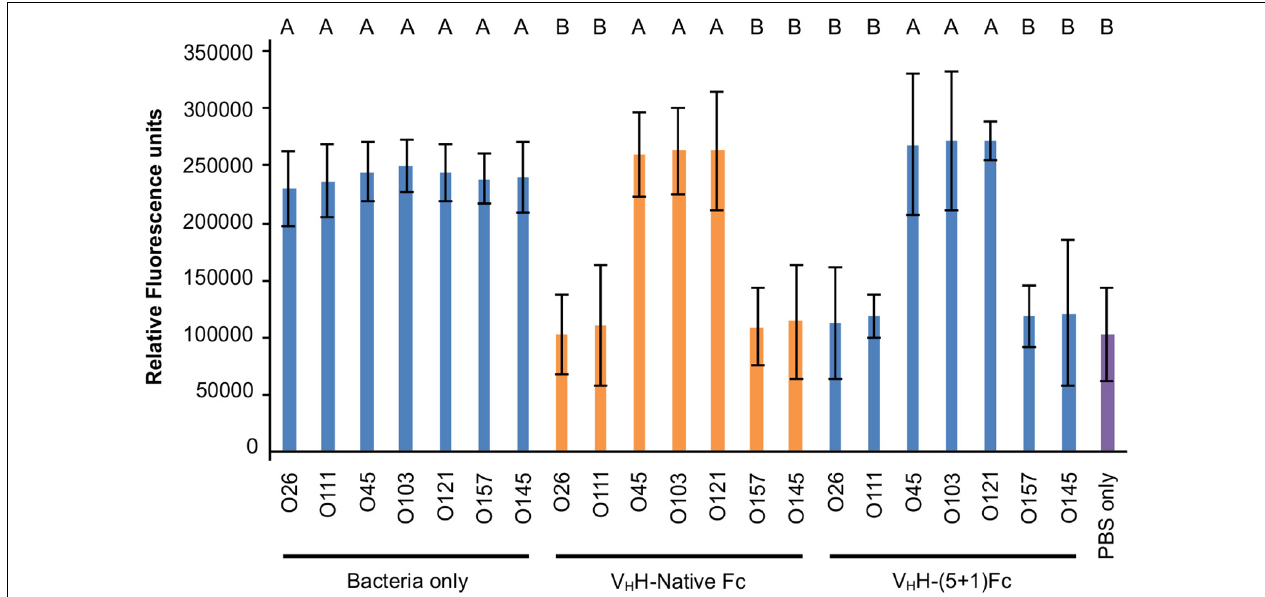
FIGURE 6 | V H H-(5 + 1)Fc neutralizes bacterial levels of O26:H11, O111:Hnm, O145:Hnm and O157:H7 to baseline levels similarly to V H H-Native Fc. Shown is the relative fluorescence of seven EHEC strains that were immunolabelled, incubated on HEp-2 cells and treated with either V H H-Native Fc, V H H-(5 + 1)Fc or with 1x PBS as a positive control. As a negative control, HEp-2 cells were incubated with 1x PBS without addition of a bacterial strain or antibody. Letters indicate a significant difference of the amount of immunolabelled adherent bacteria as determined by a one-way ANOVA with a post hoc Tukey HSD test ( p < 0.05, N = 3 biological replicates). Error bars indicate standard error of the